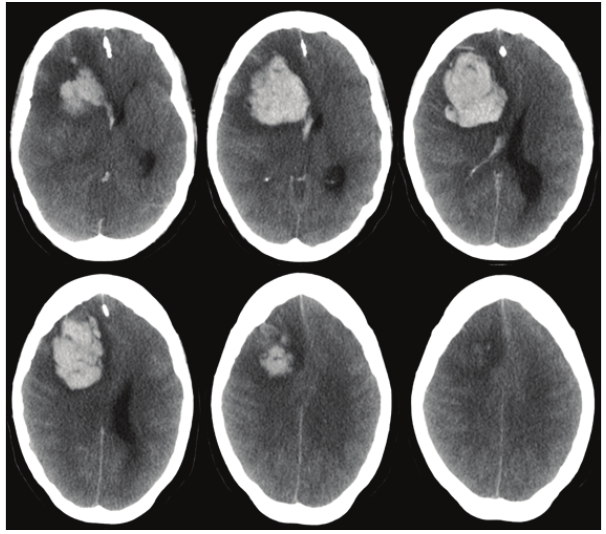
Figure 1: CT of the brain showing right frontal lobe intracerebral hemorrhage with massive brain edema, midline shift, and intraven- tricular